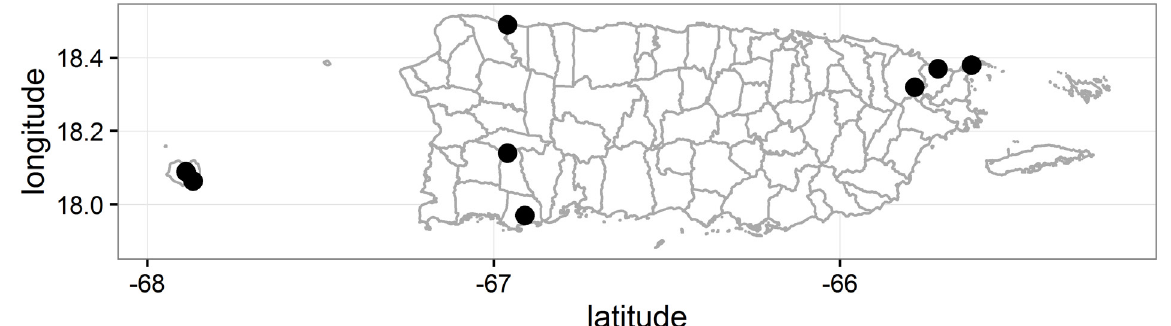
Fig. 29. Distribution map for Lasioglossum rufopanticis (Engel, 2001) in Puerto